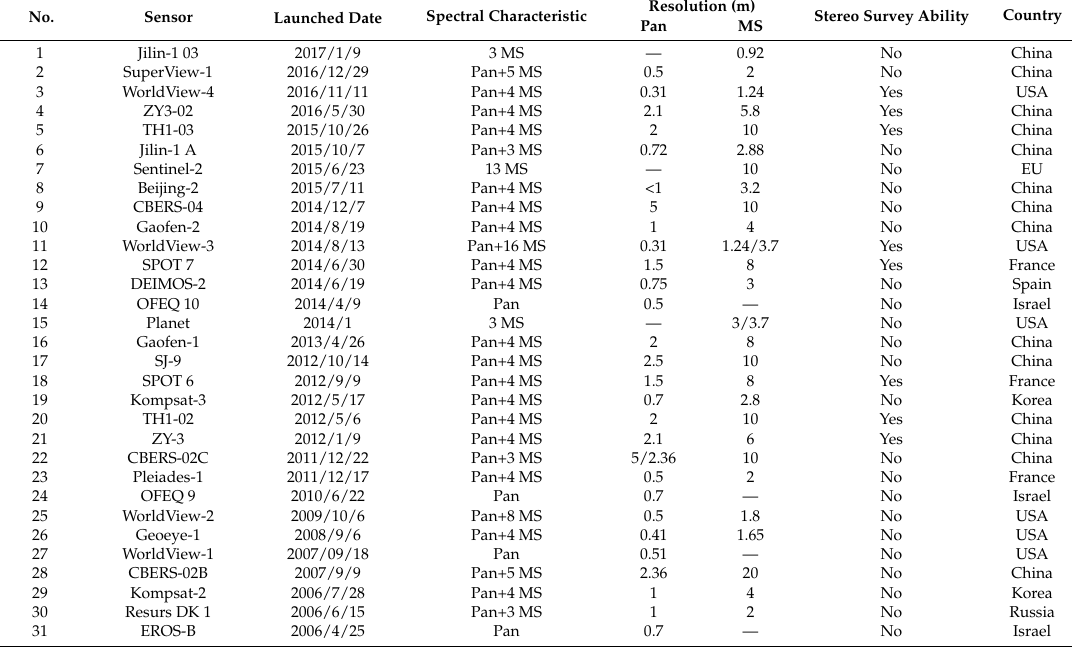
Table 5. Optical remote sensors launched successfully in recent decades with a spatial resolution higher than 10